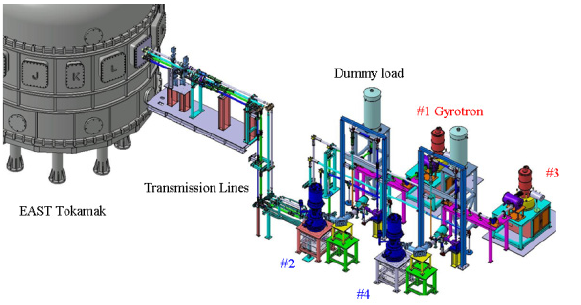
Fig. 1. The layout of gyrotron systems and transmission lines.